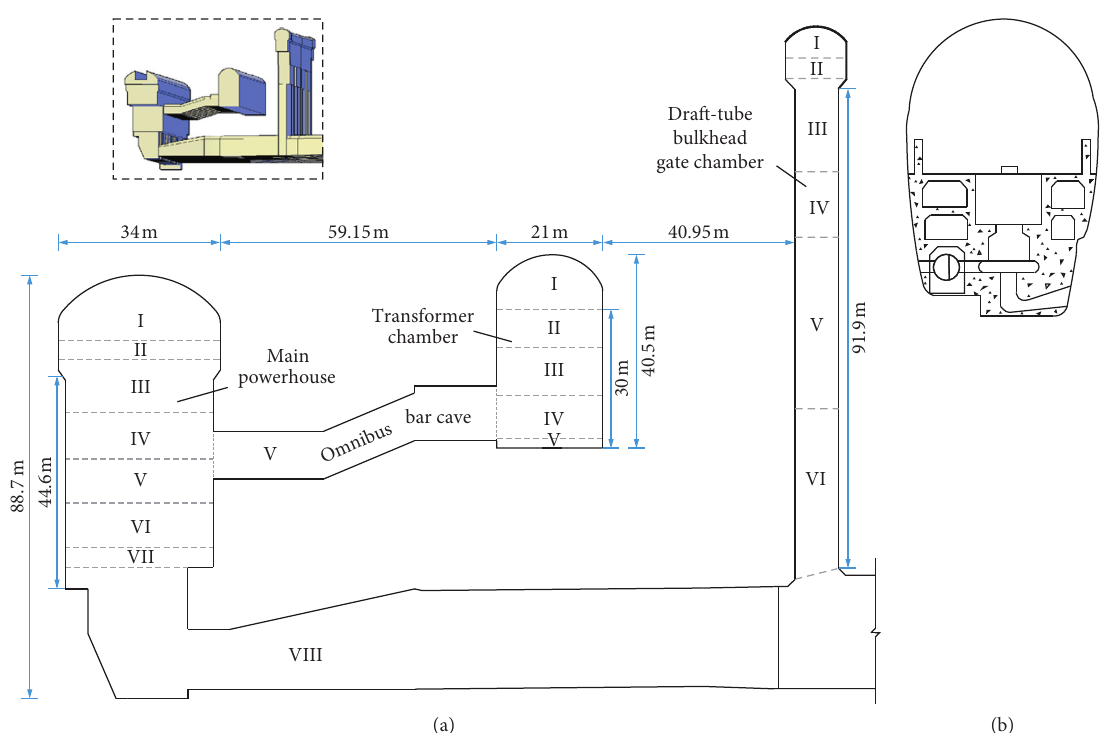
Figure 4: The section shape of (a) three main caverns of the Baihetan underground powerhouse and (b) the Imaichi underground power